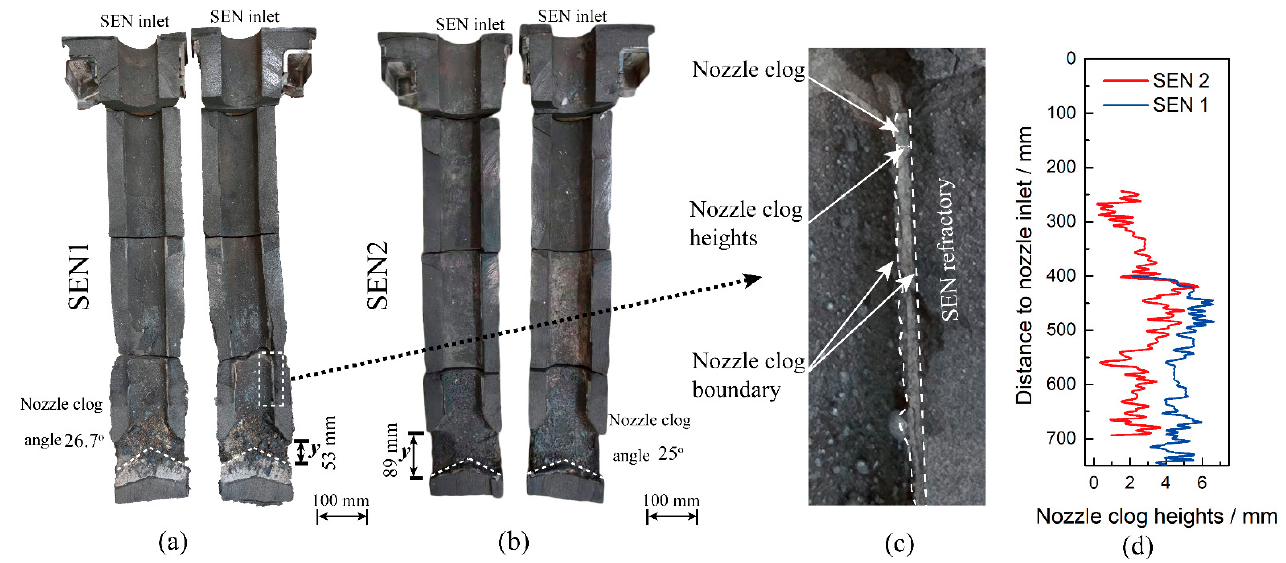
Figure 5. The macroscopic feature of the clogged SEN. ( a ) SEN1, ( b ) SEN2, ( c ) schematic of the measurement method of the nozzle clog heights, ( d ) the nozzle clog heights’